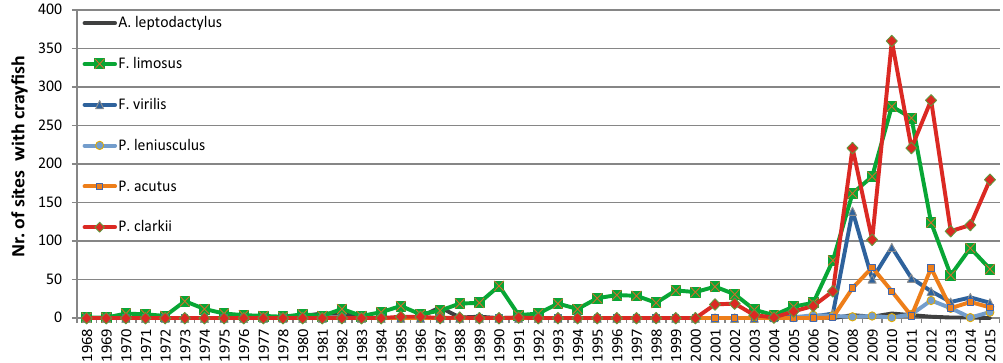
Figure 1. Number of sites with crayfish occurrences per year.